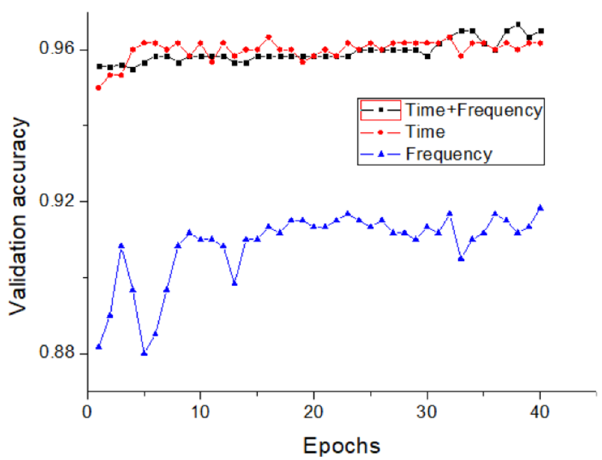
Figure 7. Validation accuracy in three kinds of model. Table 3. Validation accuracy in three penetration states (VGG16, time